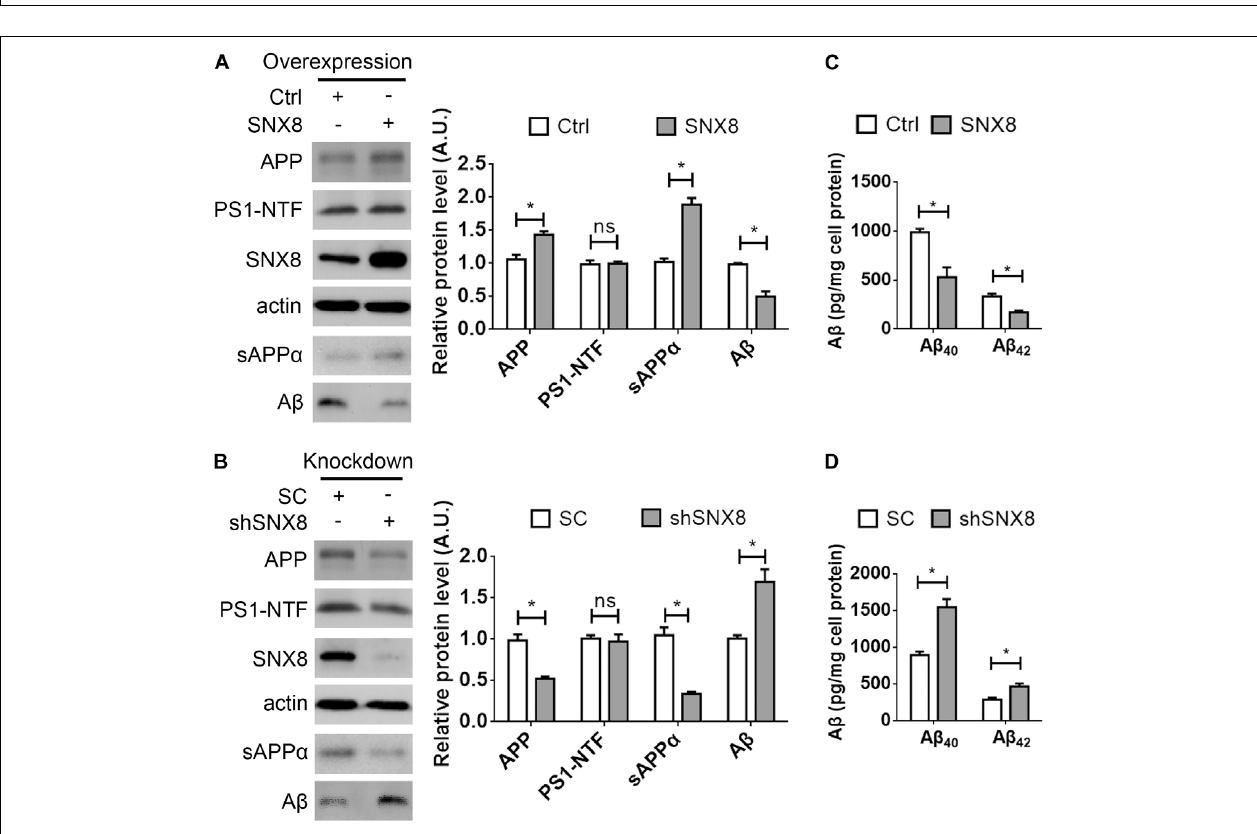
FIGURE 3 | SNX8 Modulates APP, A β , and sAPP α Levels. (A,B) HEK-swAPP cells were transfected with control (Ctrl) and SNX8 constructs for 48 h (A) , or transfected with scrambled control (SC) and SNX8 shRNA vectors (shSNX8) for 72 h (B) . Cell lysates were subjected to Western blotting for APP, PS1-NTF, SNX8, and β -actin. A β and sAPP α in conditioned media were analyzed by Western blotting (sAPP α ) or immunoprecipitation-Western blotting (A β ). APP, A β , PS1-NTF, and sAPP α band intensities were quantified by densitometry, and normalized to respective controls (set to 1.0 arbitrary unit, A.U.). n = 4, ns: not significant, ∗ p < 0.05, Mann–Whitney U test. (C,D) A β 40 and A β 42 levels in conditioned media from cells overexpressing SNX8 (C) and SNX8 knockdown (D) were determined by ELISA and compared to respective controls. n = 4, ∗ p < 0.05, Mann–Whitney U